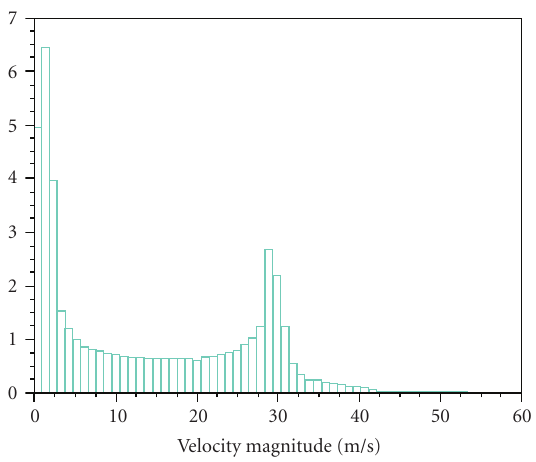
Figure 9: Bar chart showing (normalized) number of points versus velocity for FCC cell “new1” (Steady State—Average